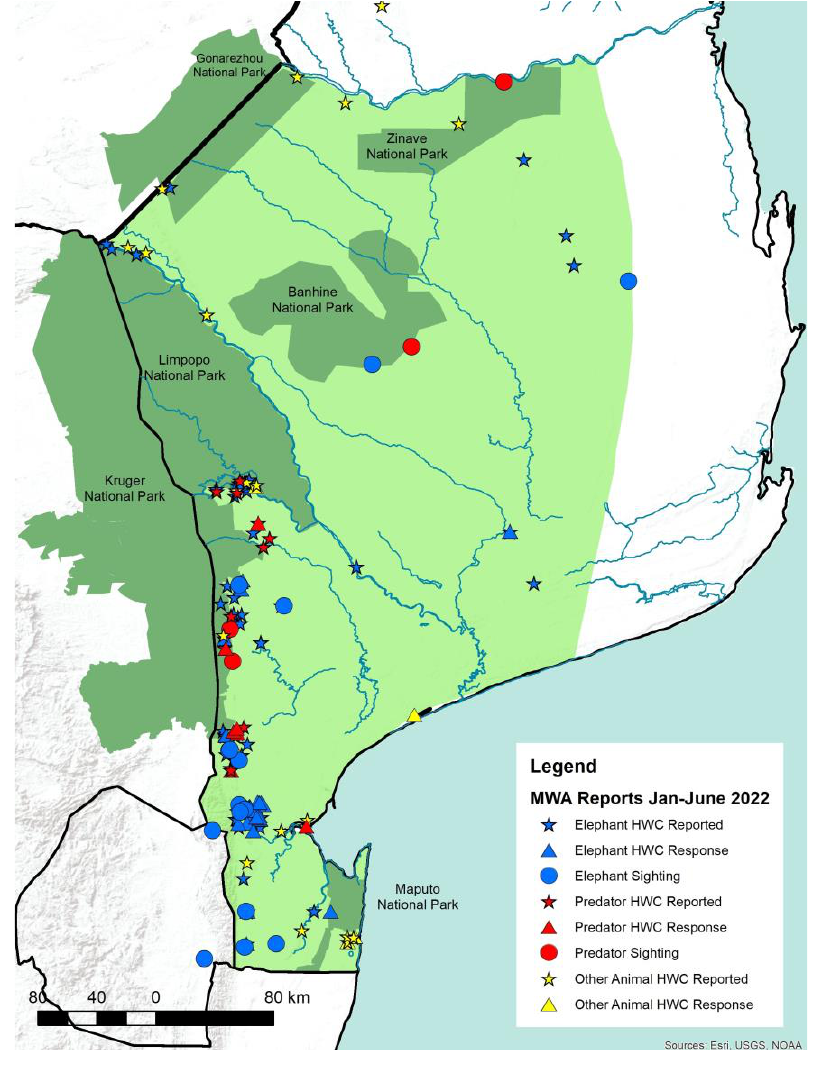
Figure 4. Human – wildlife conflict (HWC) events for a six-month period indicating that most conflict events are occurring within the corridor regions flagged by the satellite-collared animals moving between PAs.